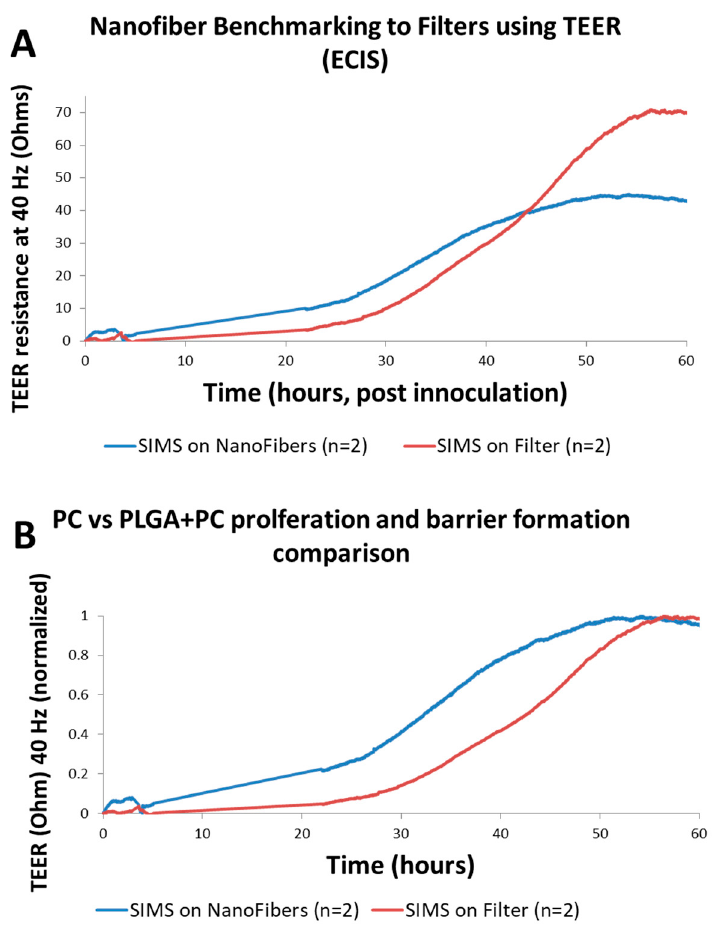
Figure 3. ( A ) Graphs indicating the TEER resistance over time of Transwells with PC membranes vs. PLGA substrates. Similar cellular behavior was observed on both substrates, confirming PLGA substrates are an effective platform for SIMS TEER studies. ( B ) Comparison between unmodified Transwell filter membranes composed of PC 0.4 μ m pore size membrane and PLGA nanofibers, using data normalized to the peak signal of each sample.